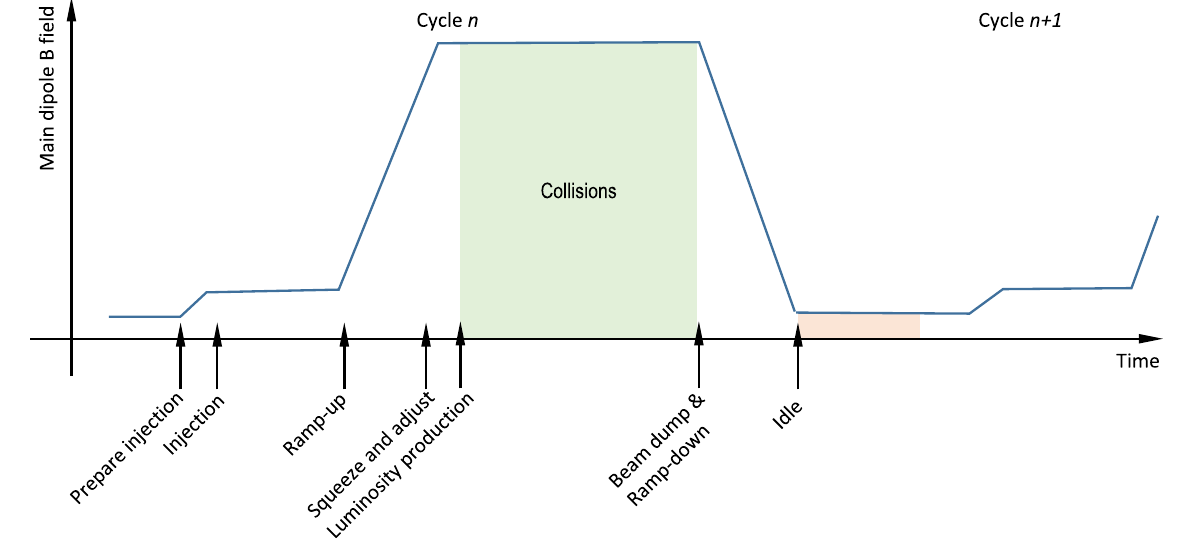
FIG. 5. Collider production cycle and cycle phases.